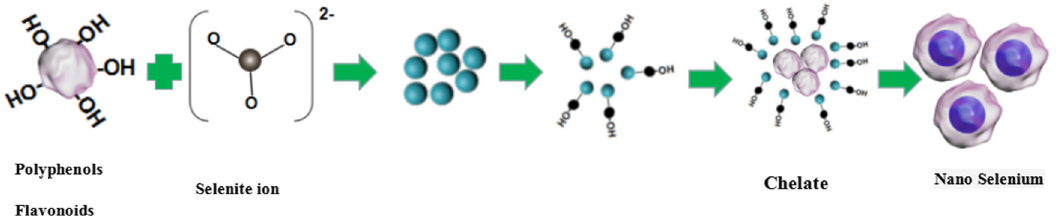
Figure 8: The mechanism of SeNPs